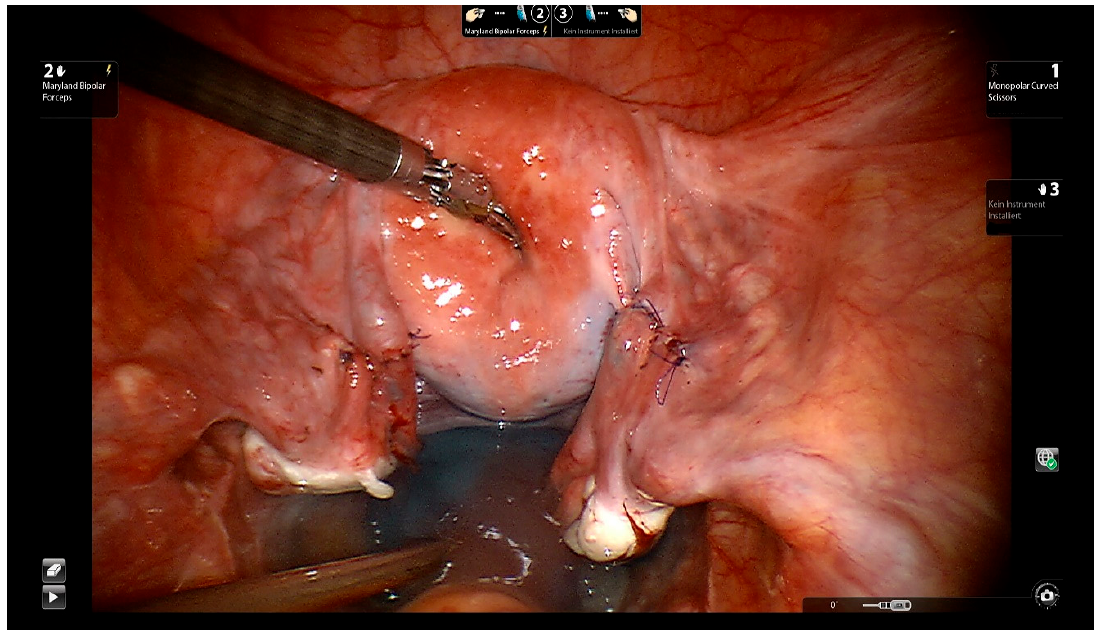
Figure 7. Closing the serosa with running 7-0 Vicryl sutures. Evaluating tubal patency by chromotubation.